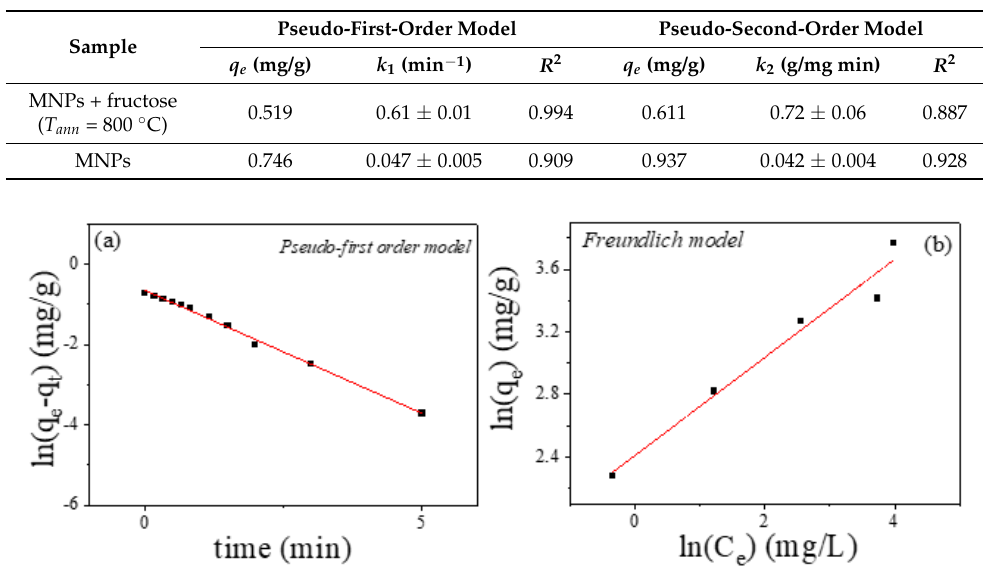
Figure 9. ( a ) Adsorption kinetics of Cr (VI) and ( b ) adsorption isotherms employing the selected annealed sample.